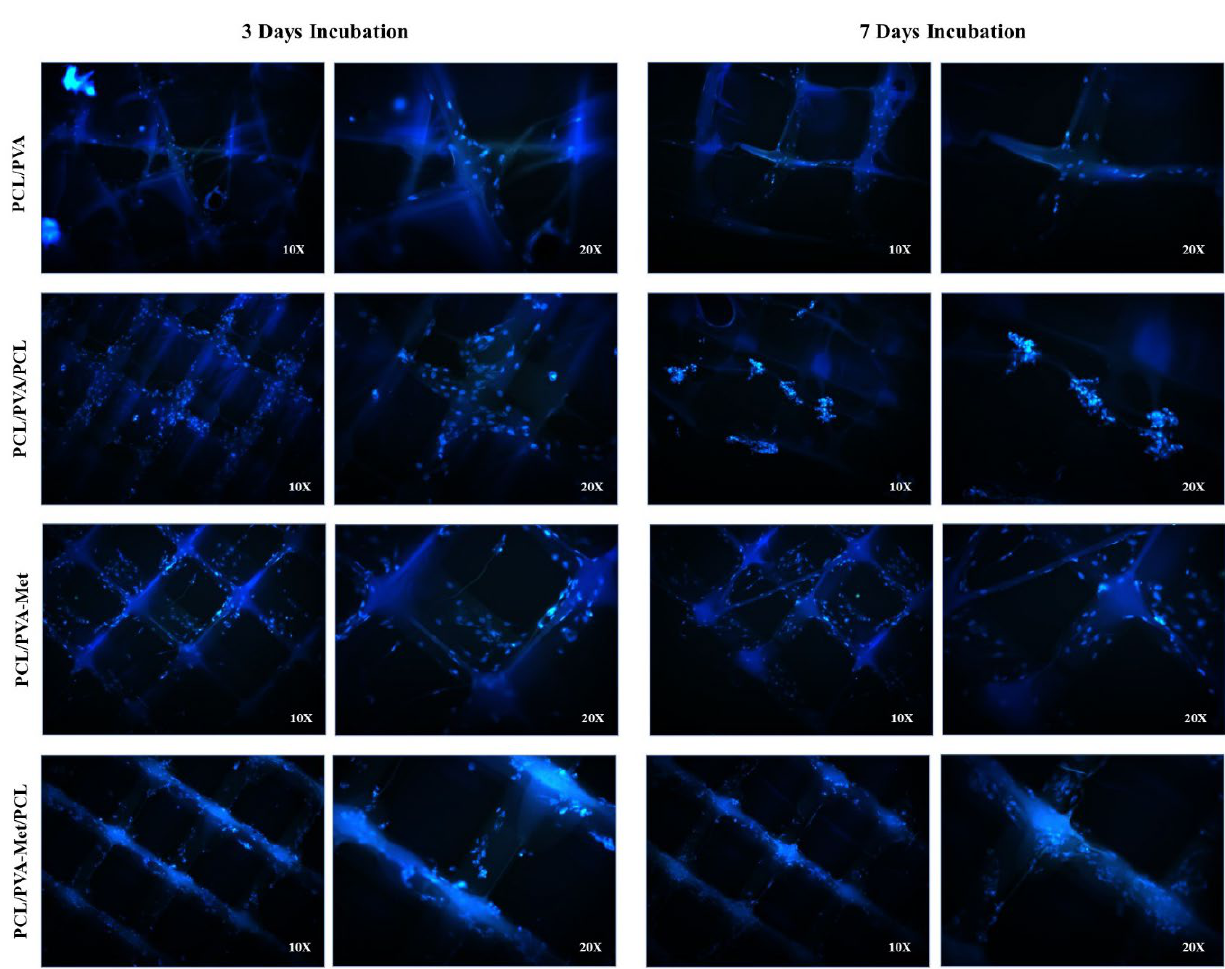
Figure 9. Fluorescent microscopy images of the DAPI stained fibroblast cells attached to the hybrid scaffolds, days 3 and 7 post-cell culture.